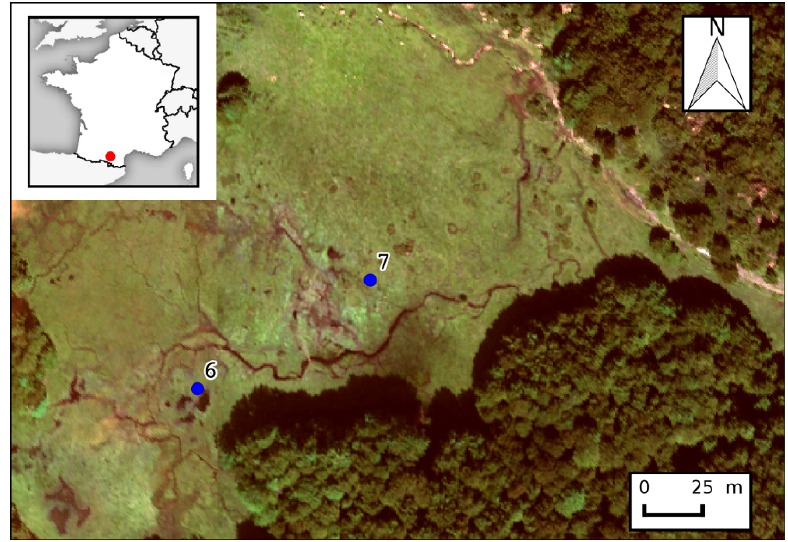
Figure A3. Location of the in situ spectroradiometer measurements for the plots of Calluna vulgaris